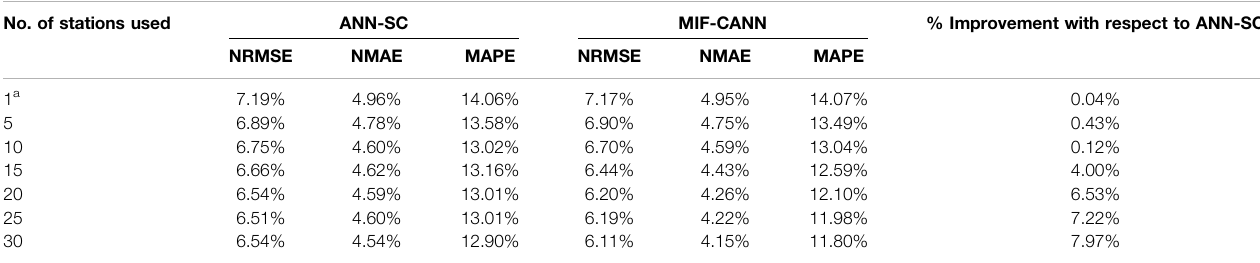
TABLE 7 | Simulation results of 2 h-ahead wind speed forecasting of the ANN-SC and MIF-CANN. No. of stations